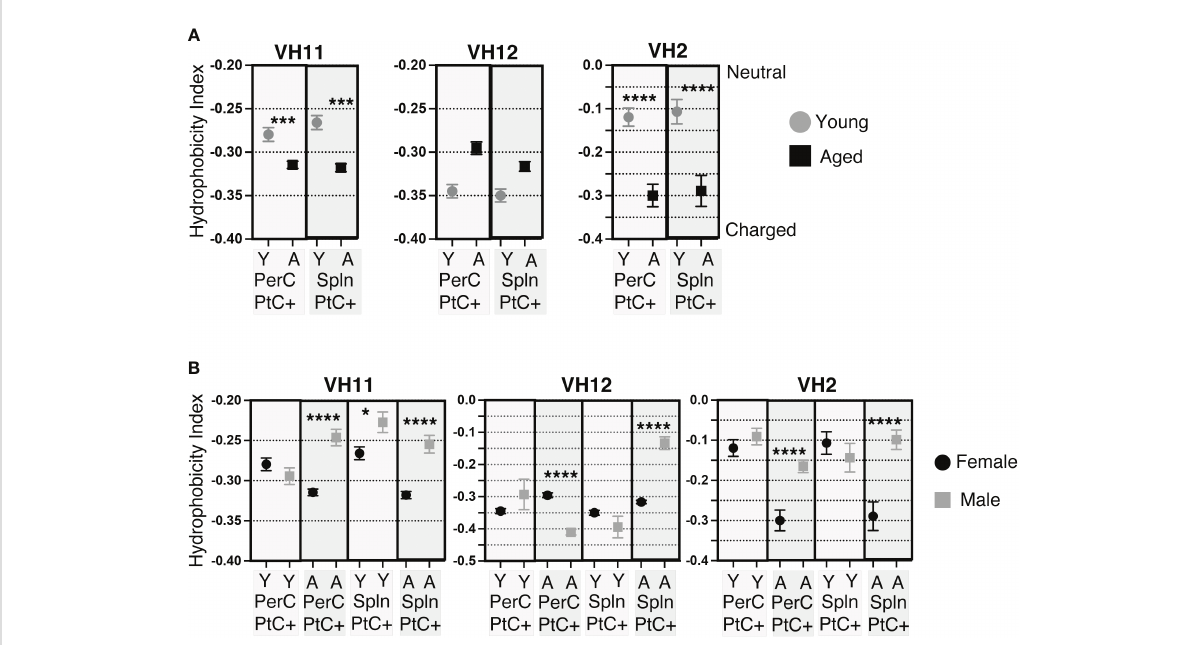
FIGURE 6 CDR-H3 hydrophobicity of PtC+CD5+ B-1 cell IgM utilizing V H 11, V H 12, or V H 2. PtC+CD5+ B-1 cells were single-cell sorted from the peritoneal cavity or spleen of young and aged female BALB/c-ByJ mice (as presented in Figure 2). “ Y ” indicates young mice (3-month-old) and “ A ” indicates aged (23-26-month-old) mice. (A) The average charge of the CDR-H3 loop region of IgM utilizing either V H 11, V H 12, or V H 2 from peritoneal or splenic PtC+CD5+ B-1 cells. (B) For direct comparisonof females and males, previously published (24) hydrophobicity analysis of young and aged male PtC+CD5+ B-1 cells is included. Female and male comparison of the average charge of the CDR-H3 loop region of IgM utilizing either V H 11, V H 12, or V H 2 from peritoneal or splenic PtC+CD5+ B-1 cells. Results are based on 4 independent experiments with sequences combined from each independent experiment (n=11 for 3-month-old mice, n=15 for 23-26-month-old female mice). Statistics used: Mann-Whitney test. Asterisks for p values: *p<0.05, ***p<0.001,